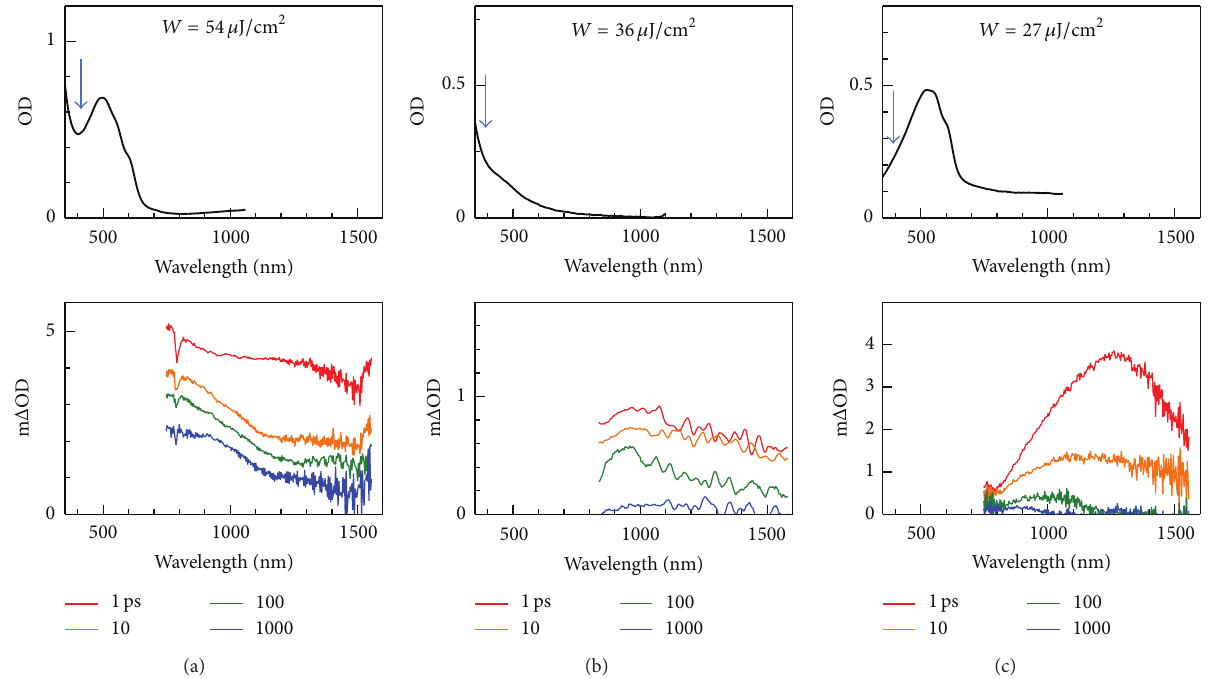
Figure 9: Δ OD spectra of (a) rr-P3HT/PCBM blend, (b) PCBM neat, and (c) rr-P3HT neat films at 300 K. Top panels show optical density (OD) of the films at 300 K. Downward arrows represent the wavelength of the pump pulse. The data were replotted from